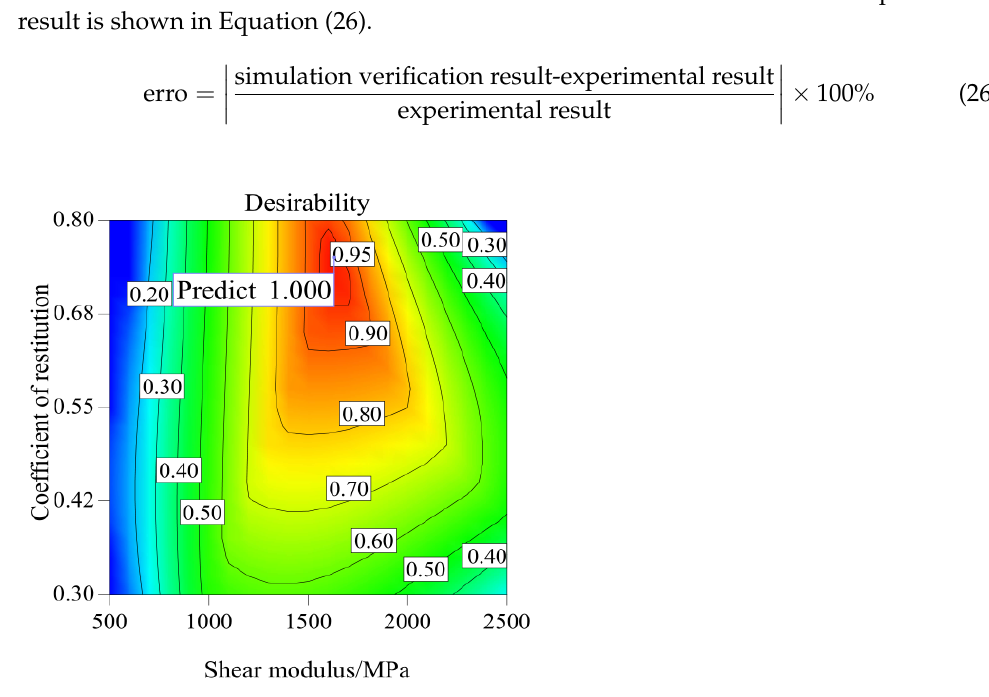
Figure 9. Contour plot of desirability with the coefficient of restitution 0.3–0.8. Table 10. Model prediction optimal parameter combination, prediction results, simulation verification results and errors between simulation verification and experimental